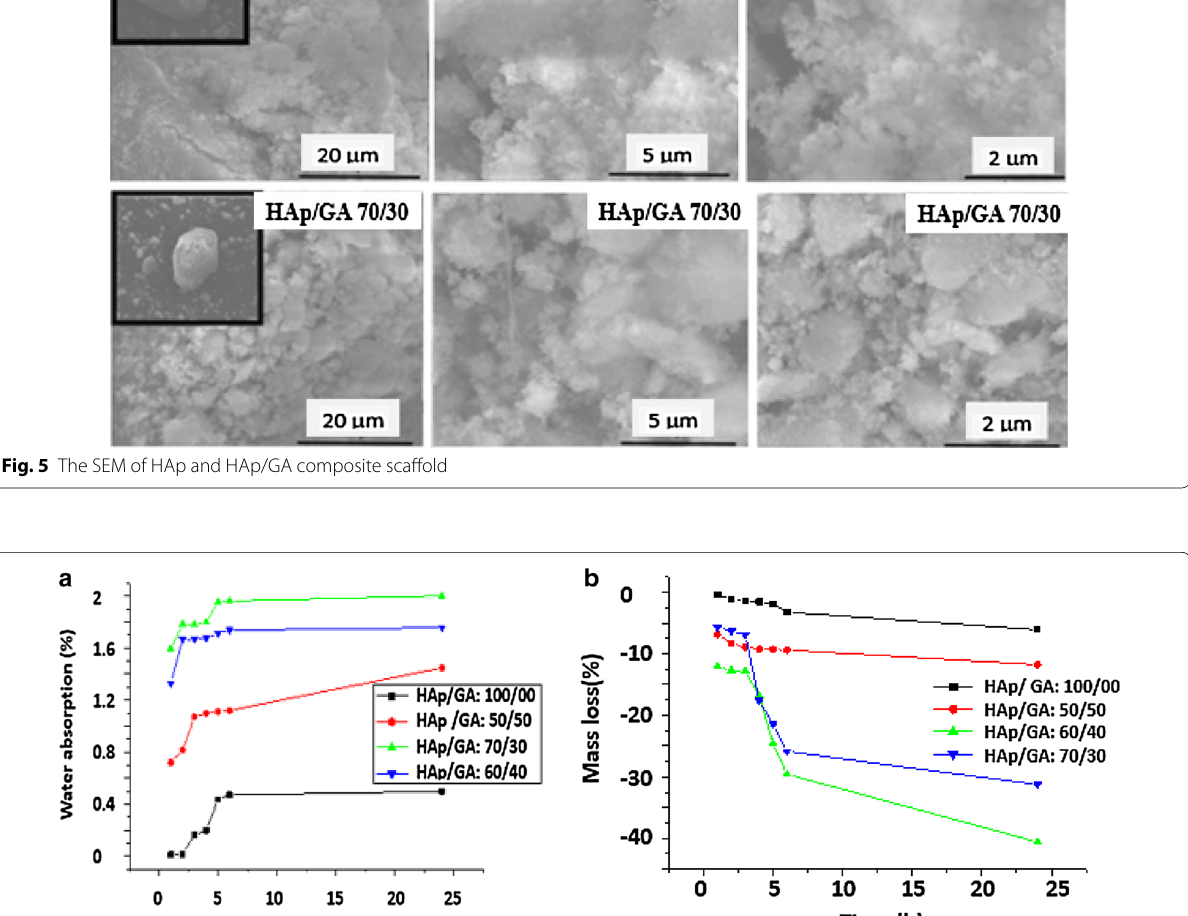
occurs. As time goes on, the adsorption sites become more saturated as shown in Fig. 9. After 15 min of con - tact time, it was noticed that the linearity of adsorption isotherm models depended on the concentration of arse- nic (III). The correlation coefficient (R 2 ) of linear Freun- dlich model is superior to the Dubinin–Radushkevich